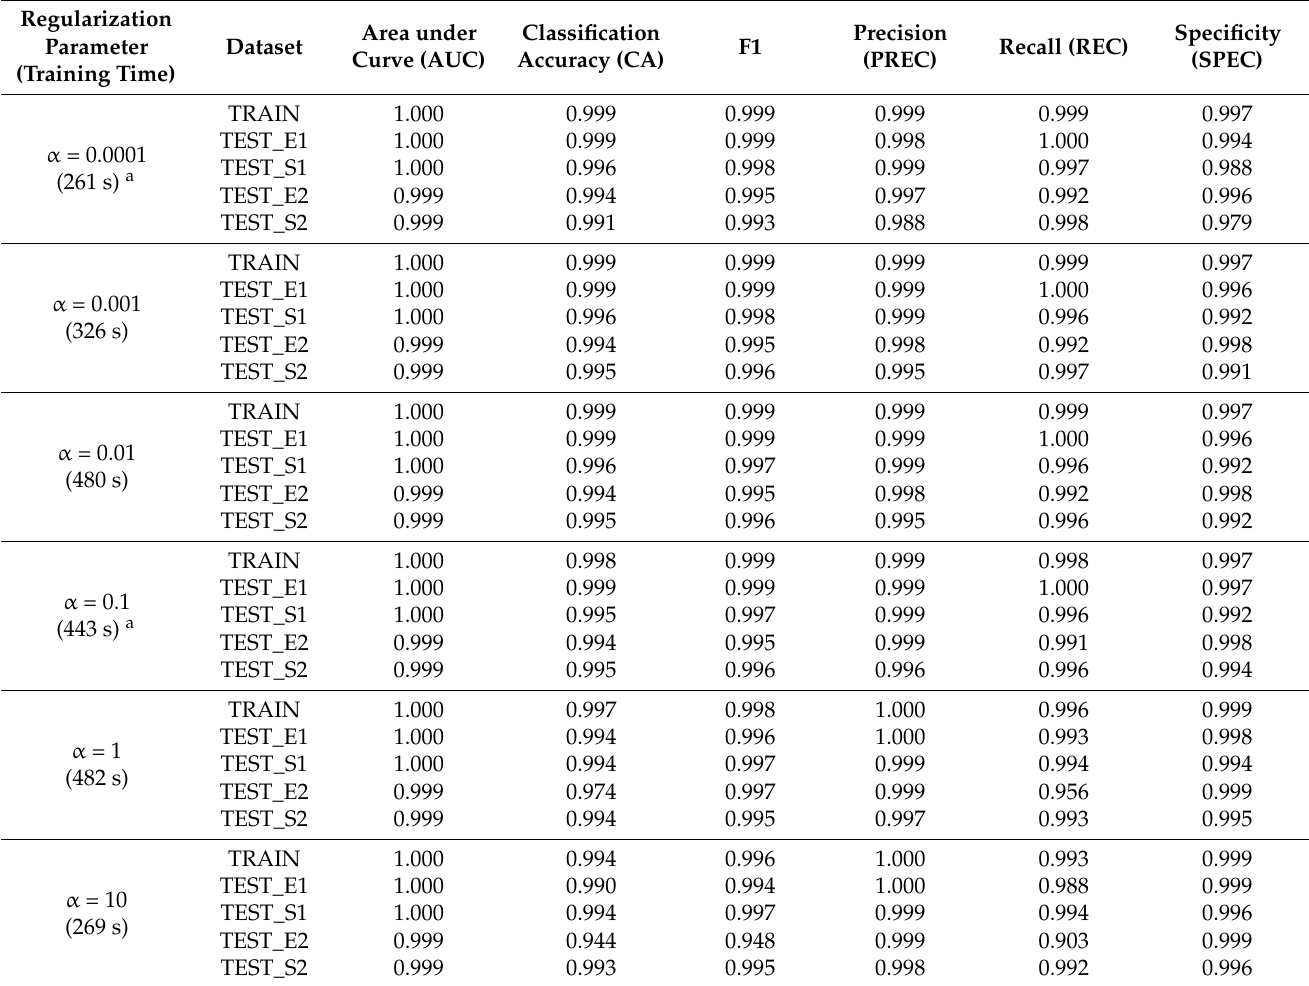
Table A2. Classification performance metrics of the training and testing datasets for ON events.